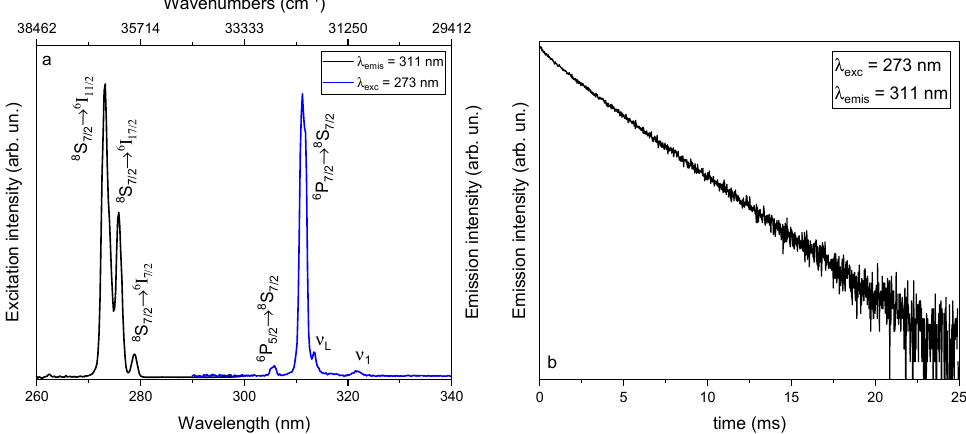
Figure 10. ( a ) Excitation spectrum of Ca 9 Gd(PO 4 ) 7 (black line) at λ emis = 311 nm. Emission spectrum of Ca 9 Gd(PO 4 ) 7 (blue line) at λ exc = 273 nm. ( b ) Decay time obtained for the compound Ca 9 Gd(PO 4 ) 7 upon excitation at 273 nm and by detecting the emission at 311 nm.